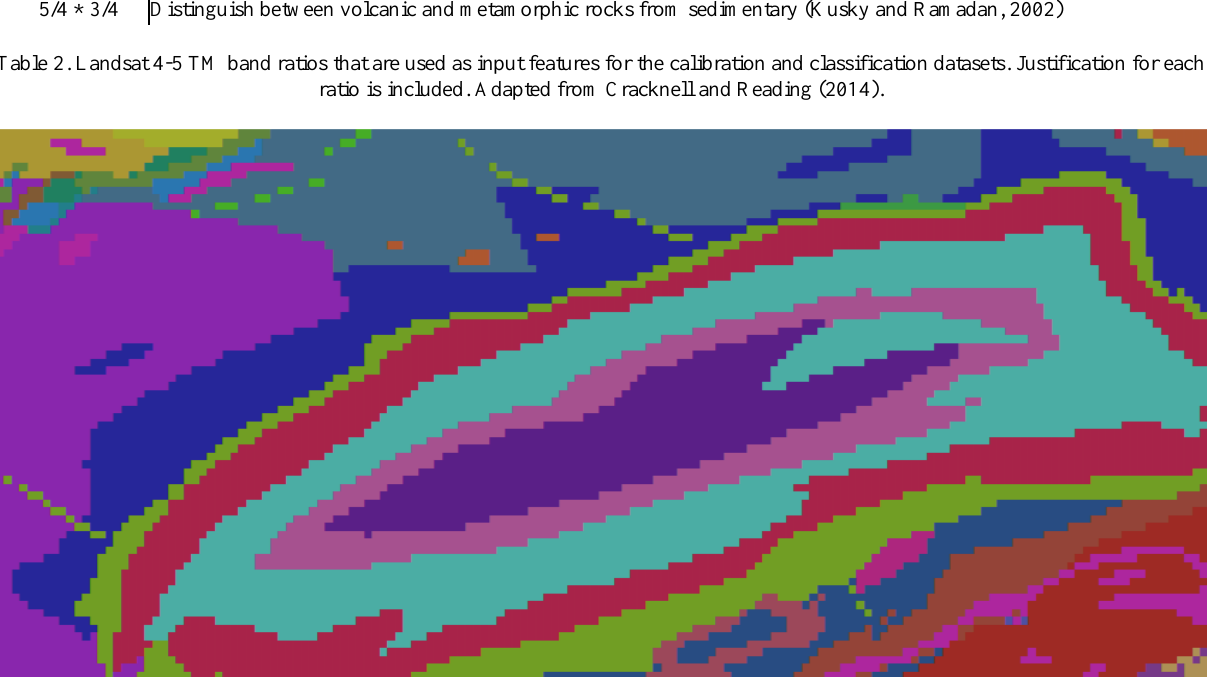
Figure 2. Rocktype map of the Sudbury Basin and surrounding area. Refer to Table 3 for legend, rocktype descriptions, and proportions within the study area (Ontario Geological Survey,